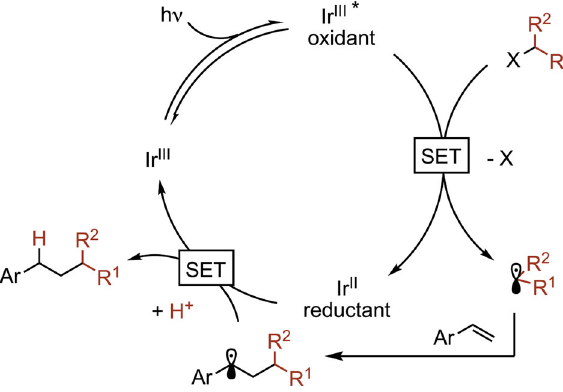
Fig. 2 Mechanistic working hypothesis. A proposed catalytic cycle for a general hydroalkylation of vinylarenes.